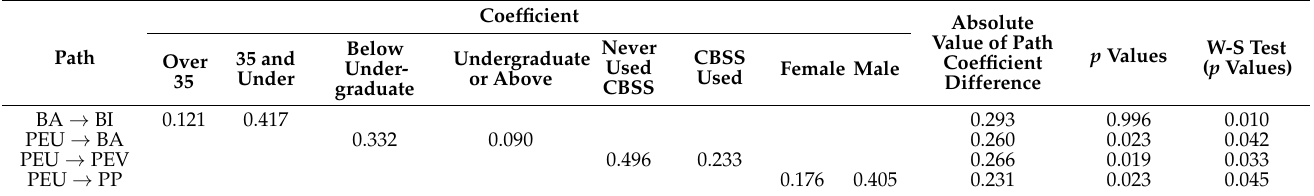
Table 10. Multigroup analysis